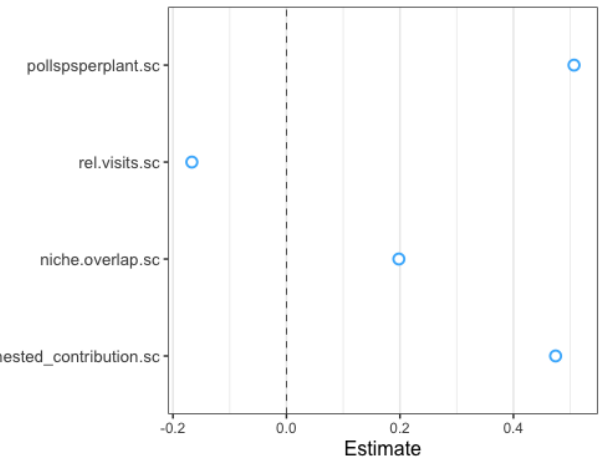
Figure S4. Forest plots showing 95% confidence intervals for all coefficients included in species-level